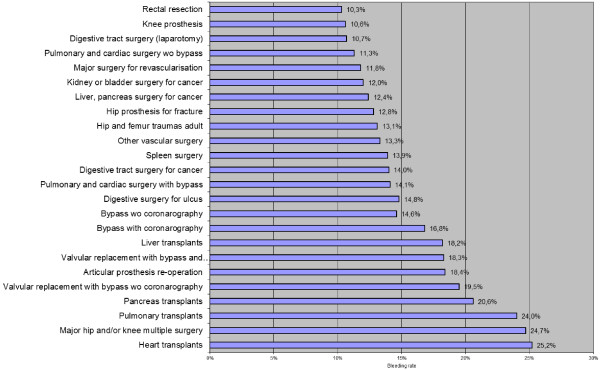
Surgical DRGs (≥10%) ranked by WB rate.